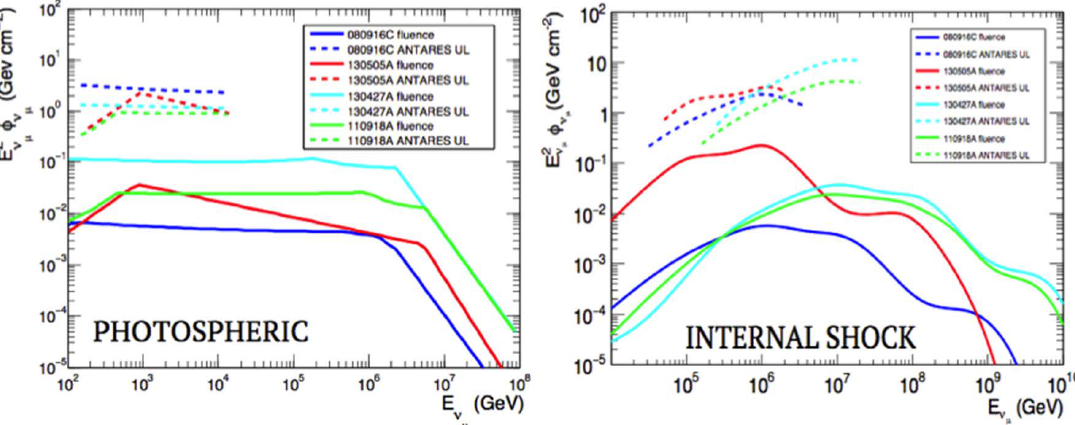
Figure 4. Solid lines: expected ν µ + ν µ fluences. Dashed lines: ANTARES 90% C.L. upper limits on selected very bright GRBs, in the energy band where 90% of the signal is expected to be detected by ANTARES. Left : internal shock model prediction. Right : photospheric model